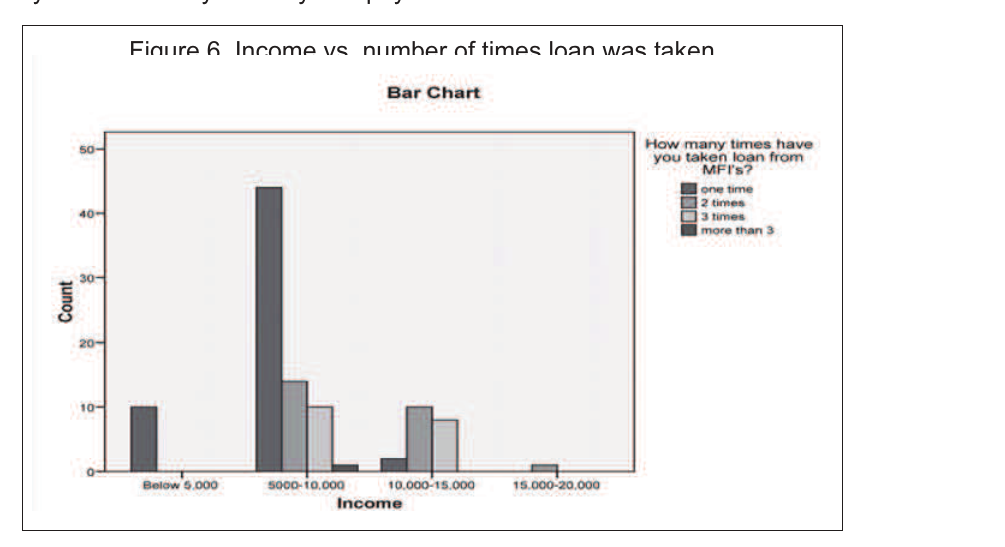
Figure 6. Income vs. number of times loan was taken